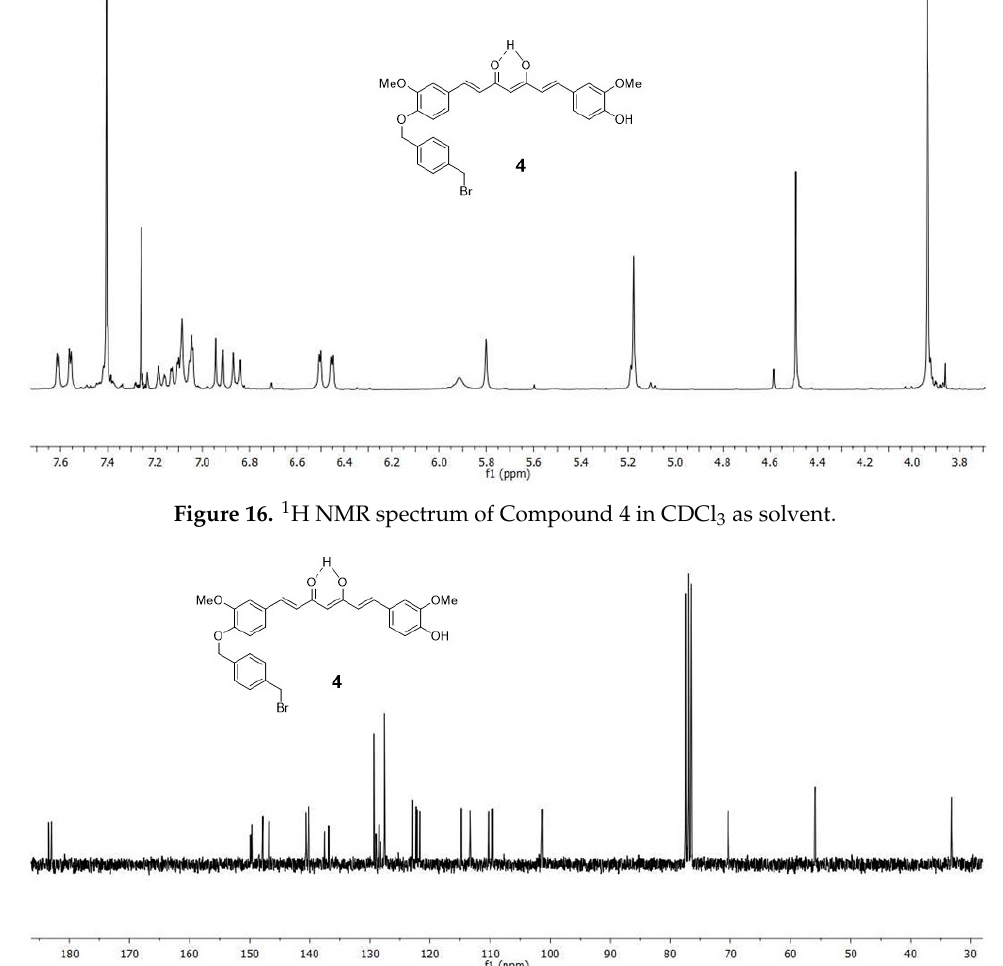
Figure 17. 13 C NMR spectrum of Compound 4 in CDCl 3 as solvent.